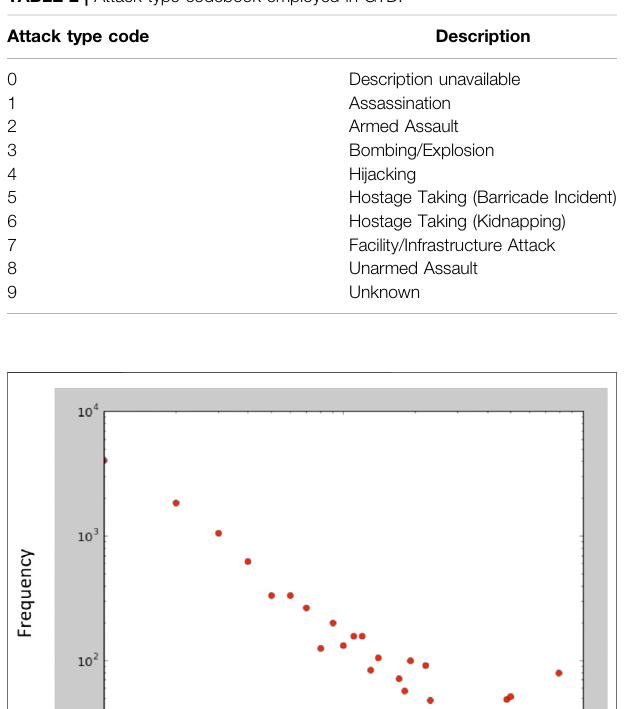
TABLE 2 | Attack type codebook employed in GTD.